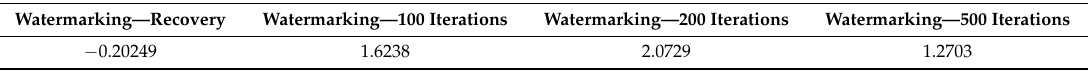
Table 7. The SNR values of the recovered speech signal with different numbers of